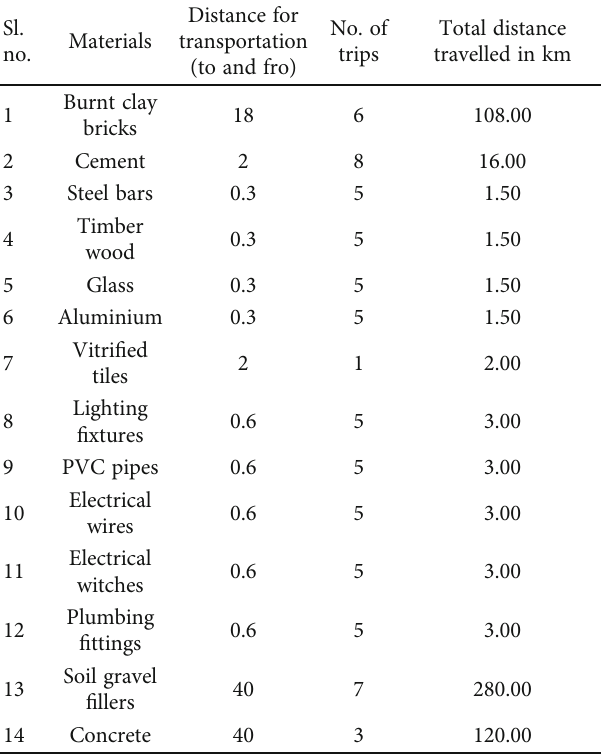
Table 4: Transportation distance of the vehicle.